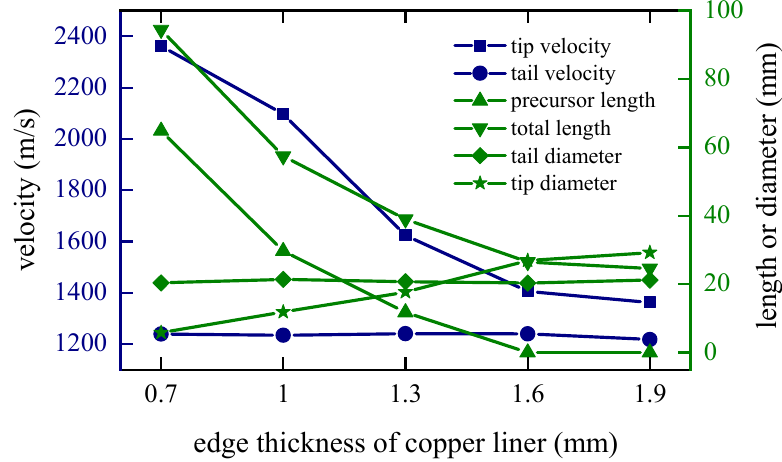
Figure 11. Curves of coating EFP shape parameter change.